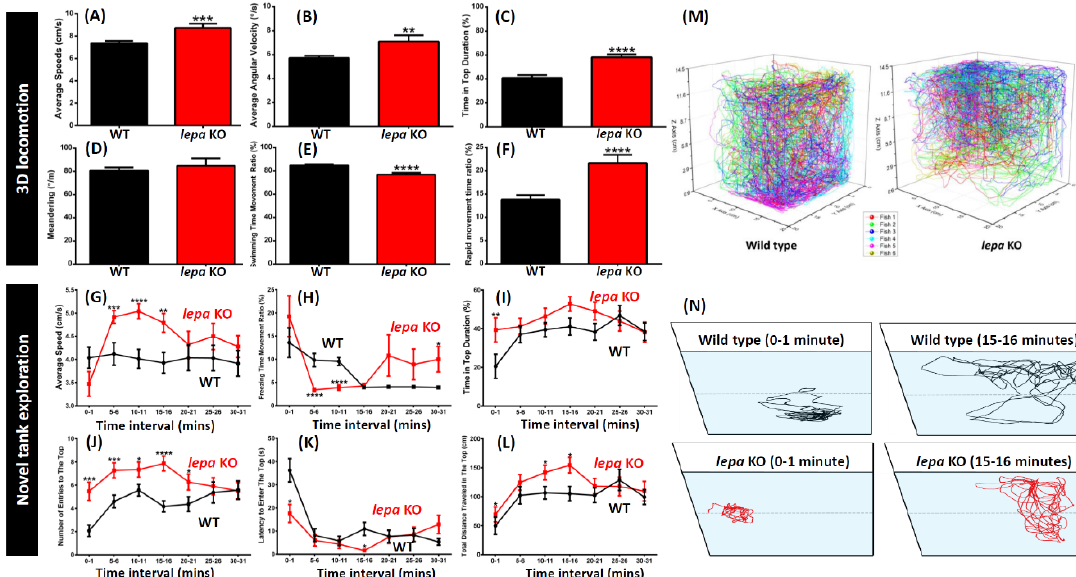
Figure 2. Comparison of several untreated wild type and lepa KO zebrafish behavioral endpoints in 3D locomotion test and novel tank exposure test within 30 min: ( A ) Average speed; ( B ) average angular velocity; ( C ) duration time in top of the tank; ( D ) meandering; ( E ) swimming time movement ratio; ( F ) rapid movement time ratio; ( G ) average speed; ( H ) freezing time movement ratio; ( I ) duration time in top of the tank; ( J ) number of entries to the top of the tank; ( K ) latency to enter the top of the tank; and ( L ) total distance travelled in the top of the tank. ( M ) Locomotion trajectory of wild type (left) and lepa KO (right) zebrafish. The three-dimensional locomotion trajectories of six fish were recorded and analyzed by using idTracker software. ( N ) Locomotion trajectory of wild type (black color) and lepa KO (red color) zebrafish in novel tank test. The locomotion for 0–1 min (left) and 15–16 min (right) windows were recorded and analyzed by using idTracker software. The data from 3D locomotion test ( A – F ) are expressed as the mean ± SEM and analyzed by unpaired t-test ( n control = 40; n lepa KO = 30; ** p < 0.01, *** p < 0.001, **** p < 0.0001). The data from novel tank test ( G – L ) are expressed as the mean ± SEM and analyzed by Mann–Whitney test ( n = 30; * p < 0.05, ** p < 0.01, *** p < 0.001, **** p < 0.0001).